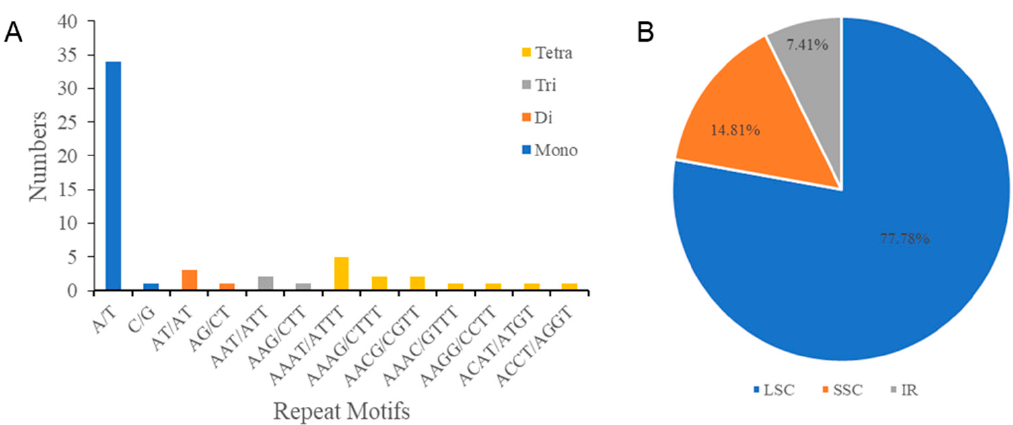
Figure 3. SSRs in the cp genome of I. lipoensis . ( A ) Quantification of various categories of SSRs. ( B ) Percentages of repeats in the LSC, IR, and SSC locations.